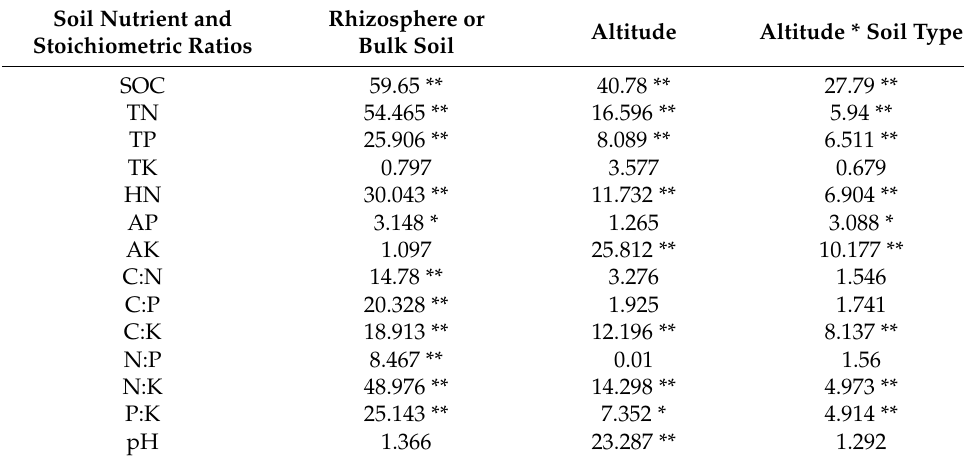
Table 2. Two-way ANOVA of soil nutrients and stoichiometric ratios (F-value). Soil Nutrient